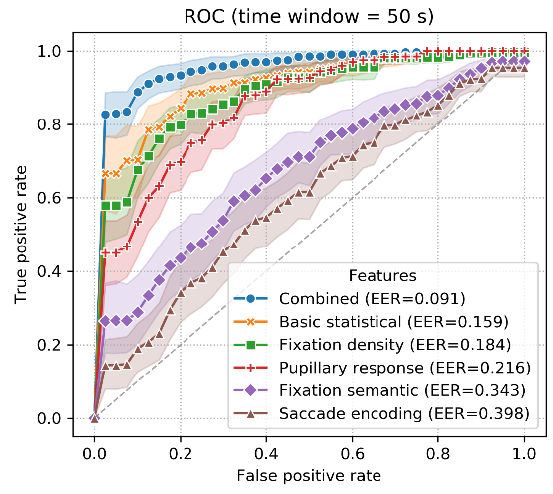
Figure 12. ROC curve for the verification scenario (T win = 50 s).